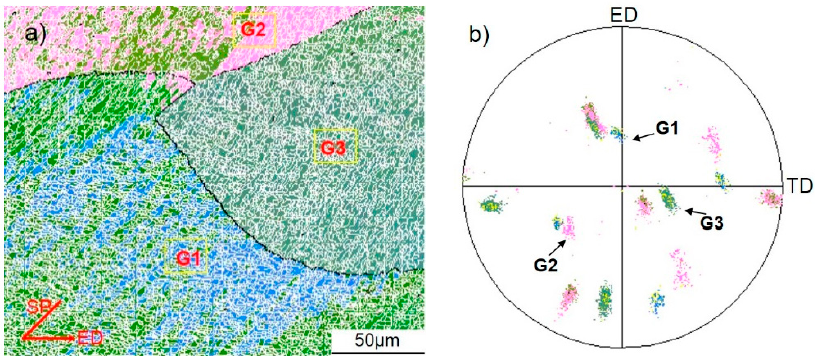
Figure 4. ( a ) EBSD map, showing the substructural alignment in grains of different orientations and ( b ) (111) pole figure, showing the orientations of the individual grains—after the 1st pass ECAE.